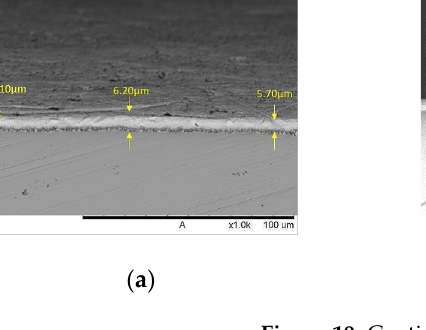
Figure 20. Average resistance vs the percentage of AgNP.